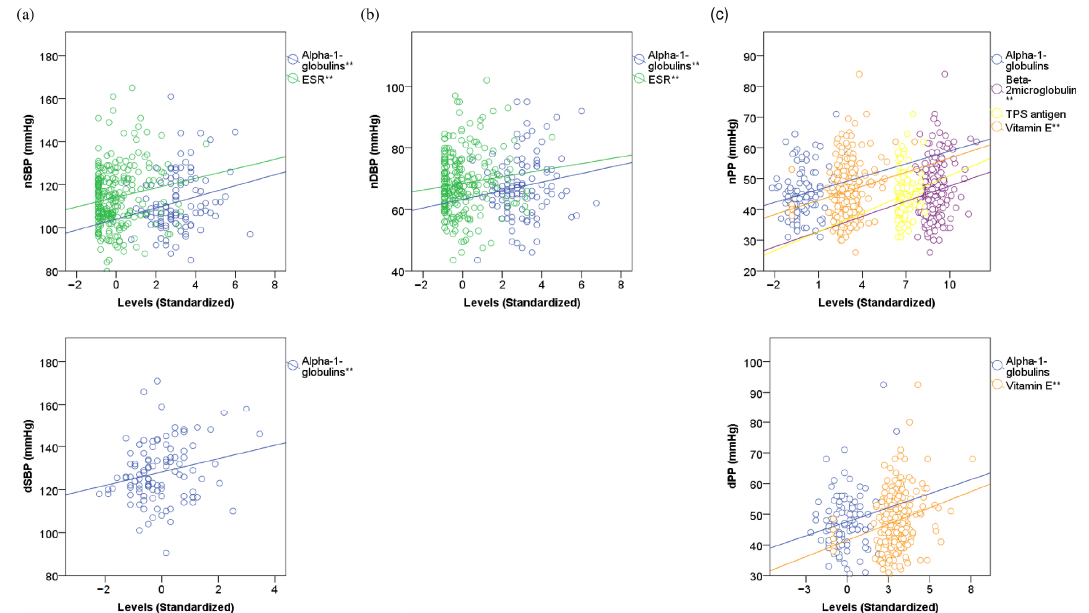
Figure 2. Linear correlations of 24-h ambulatory blood pressure monitoring indices with inflam- matory and redox markers. The Scatter plots represent the correlations between 24-h ambulatory blood pressure monitoring indices and inflammatory and redox markers. Correlation coefficients and standard errors are shown in Supplementary Table S1. ( a ) Night-time and daytime systolic blood pressure. ( b ) Night-time diastolic blood pressure. ( c ) Night-time and daytime pulse pres- sure. SBP ― Systolic blood pressure. DBP ― Diastolic blood pressure. nSBP ― Average night-time SBP. dSBP ― Average daytime SBP. nDBP ― Average night-time DBP. dDBP ― Average daytime DBP. nPP ― nocturnal pulse pressure. dPP ― daytime pulse pressure. ESR ― Erythrocyte sedimenta-